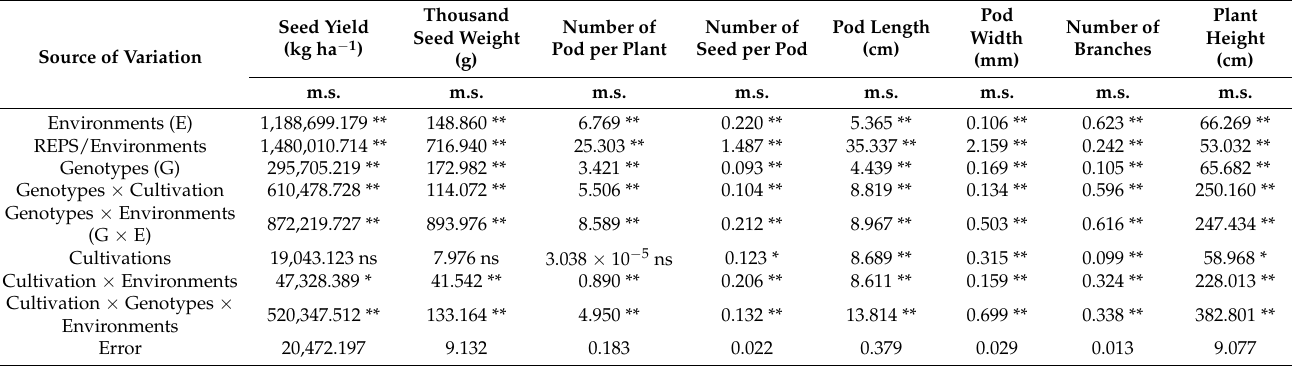
Table 1. Mean squares (m.s.) from analysis of variance over environments and cultivation methods for tested traits: seed yield (kg ha − 1 ), thousand seed weight (g), number of pod per plant, number of seed per pod, pod length (cm), pod width (mm), number of branches and plant height (cm).